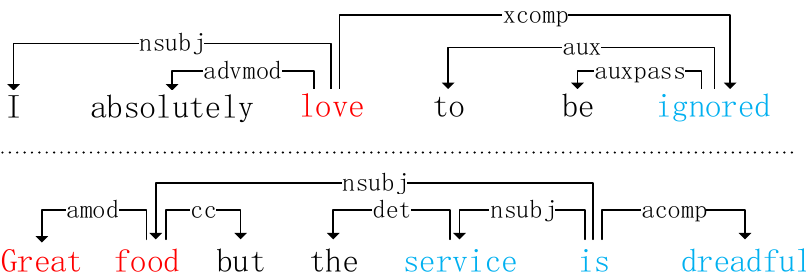
Figure 1. The figure shows two examples of tweets with dependency. The above sentence is sarcastic tweet and the below is not sarcastic. The words or snippets with incongruity are